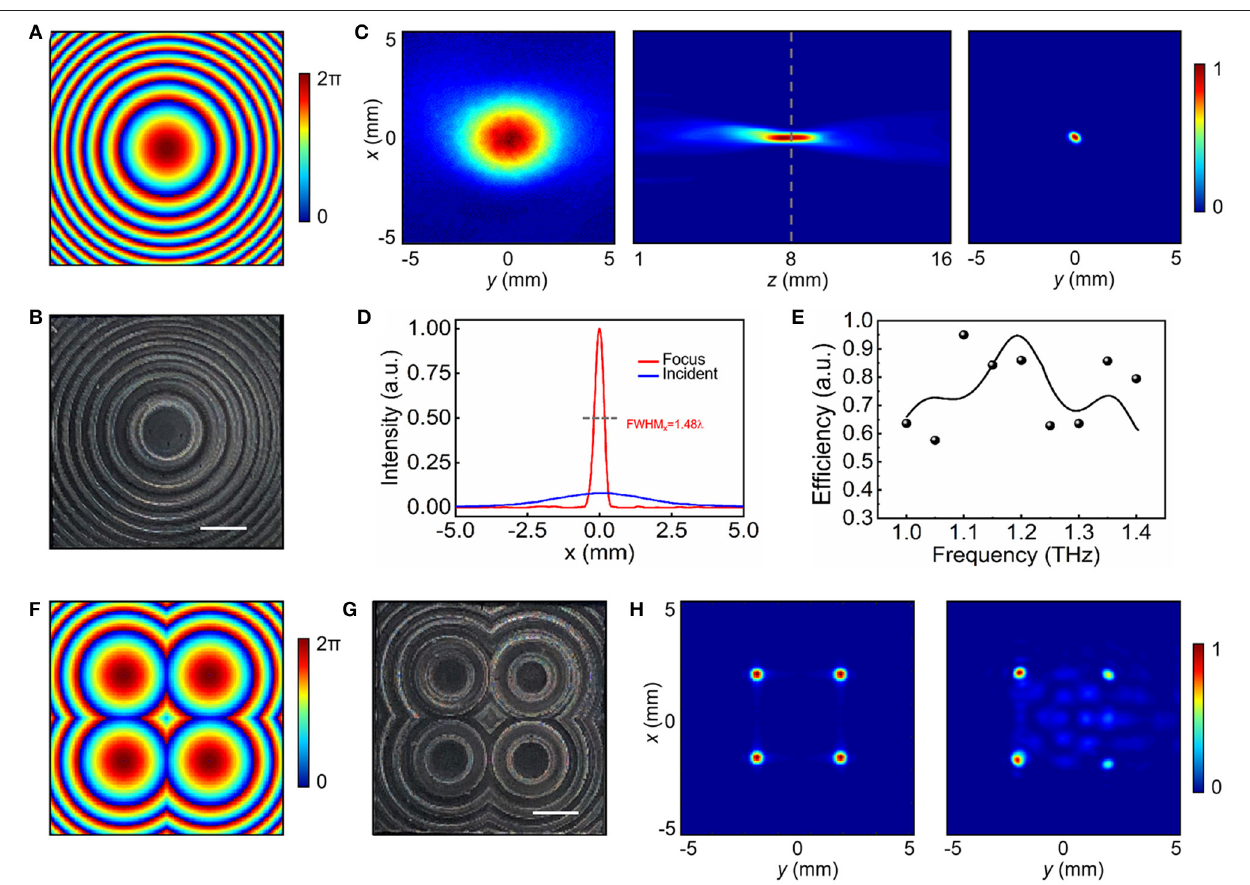
FIGURE 2 | Metalens and metalens array. (A) Designed phase diagram and (B) photograph of a metalens. (C) THz intensity distributions of incident wave in the xy -plane (left), beam propagation in the xz -plane (middle), and focal spot in the xy -plane (right). (D) Intensity profiles of incident wave (blue) and focal spot (red). (E) Simulated (line) and measured (dot) efficiencies of the metalens. (F) Designed phase diagram and (G) photograph of a metalens array. (H) Simulated (left) and measured (right) intensity distributions in the focal plane. All scale bars indicate